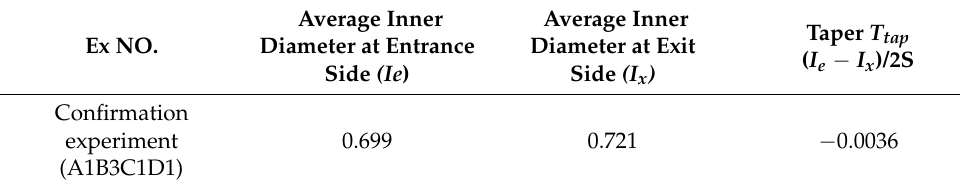
Table A7. Confirmation experimental results for taper.